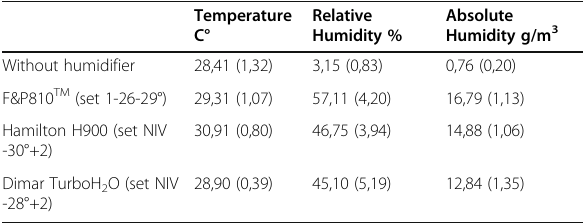
Table 2 (abstract A196). Full face mask CPAP Temperature